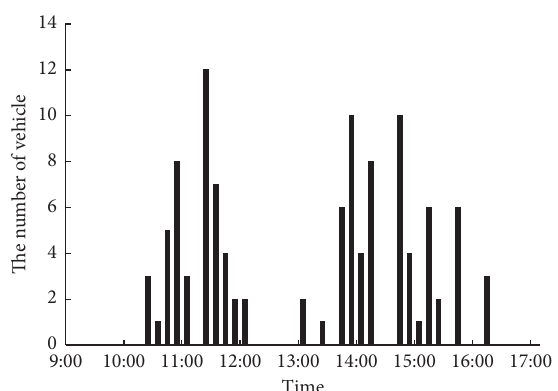
Figure 6: Distribution plan between Song Lei Peace Community.